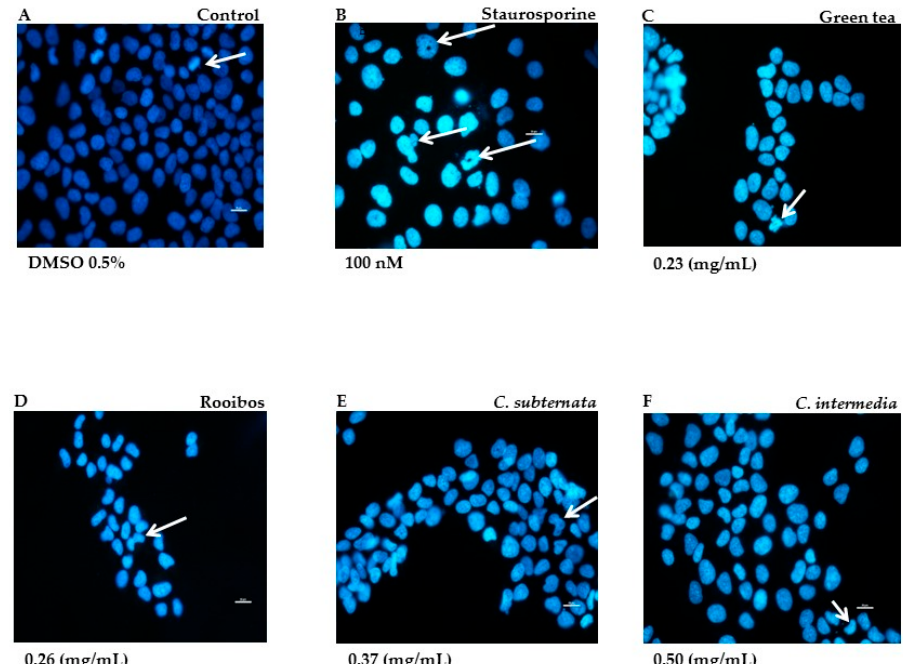
Figure 1. Morphological features in cells stained with Hoechst after 24 h incubation in the presence of green tea and the various tea/herbal tea extracts. Untreated cells displayed dimly stained nuclei; arrow indicates pro-metaphase ( A ). Positive control cells were treated with staurosporine (100 nM; ( B )) Arrows indicate unstained nucleolar region (chromatin condensation) nuclear fragmentation and formation of apoptotic bodies. Cells exposed to methanol extract of green tea ( C ) show nuclear fragmentation. Rooibos ( D ) treated cells show crescent shape figures (arrow). Effects of aqueous extracts C. subternata and C. intermedia depicted in ( E , F ) also displayed similar features, but also with blebbing. Bar = 20 µM; Magnification 40×.